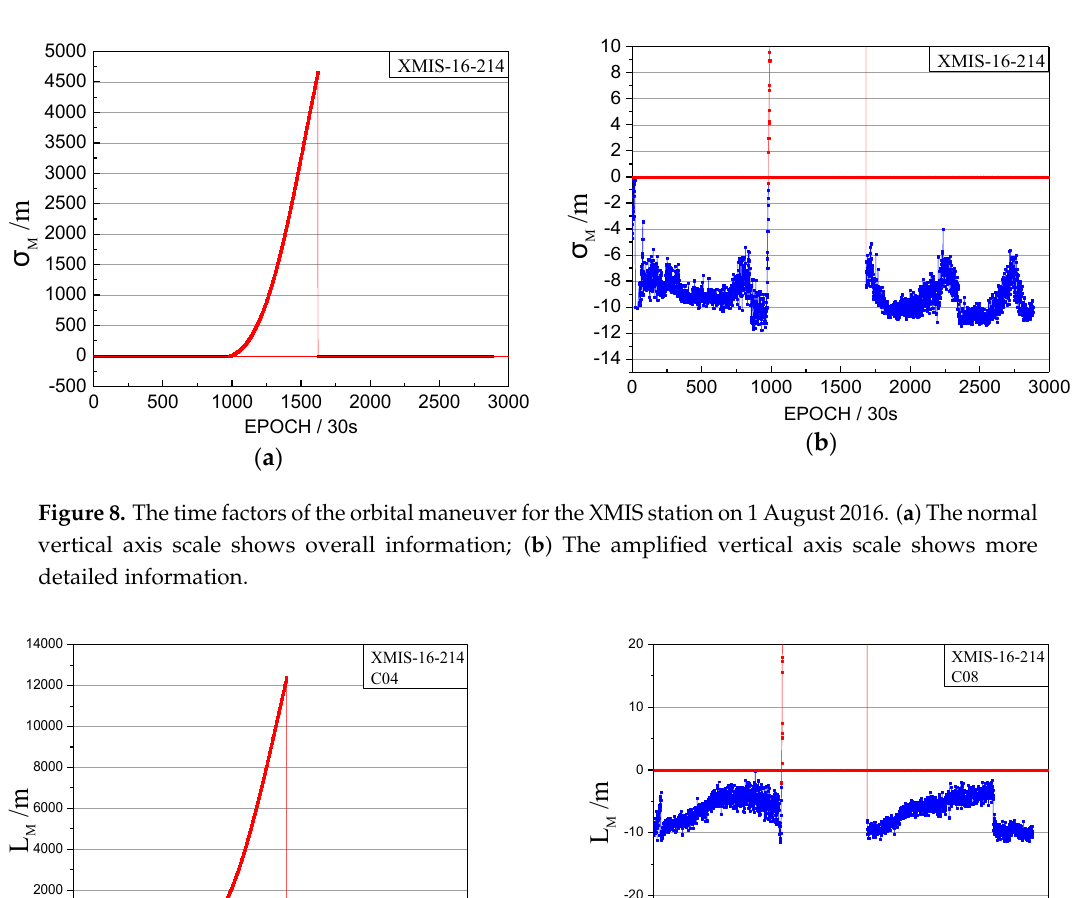
Figure 10. The health marks of C08 in the broadcast ephemeris. The red box highlights are the unhealthy status marked 1. The blue box highlights are the healthy status marked 0. Note the data from between 08:00 and 12:00 is not displayed to limit the size of the figure, and the healthy status are all marked 1 during this period. In Figure 10, the health status of satellite C08 in the broadcast ephemeris is marked as unhealthy from 07:00 to 13:00. The PRN is correctly detected as C08 by the proposed method. The start time of the orbital maneuver detected for C08 is 08:05:30 (between 07:00 and 13:00). As is known, once the orbit maneuvers begin, the precision orbit cannot be determined because of the orbital maneuver leads to kinetic empirical parameters failing. The header of the precise orbits information removed the C08 satellite, as shown in Figure 11, which is secondary proof of the orbital maneuver for C08.